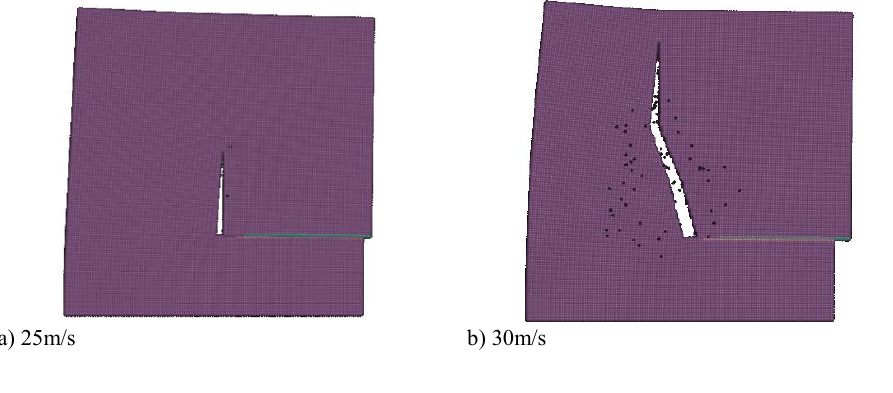
Fig. 6. Numerical results after impact velocity of 25m/s (left) and 30m/s (right). To be compared with